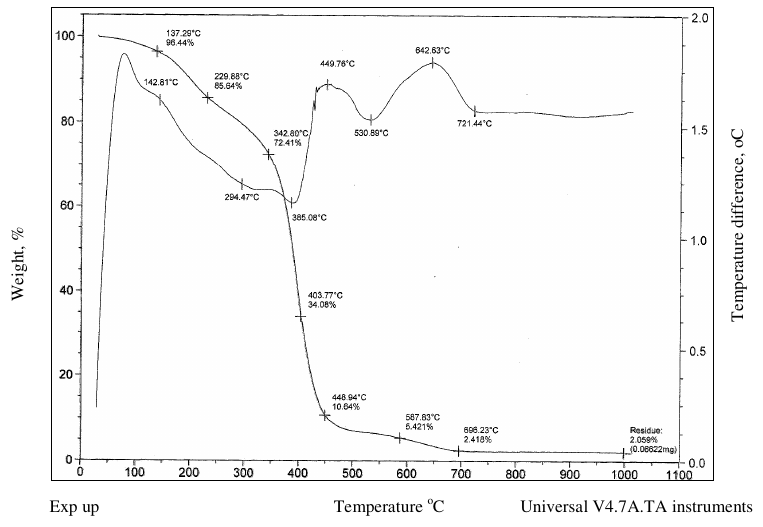
Figure 9. The TGA-DTA curve for OLIVA